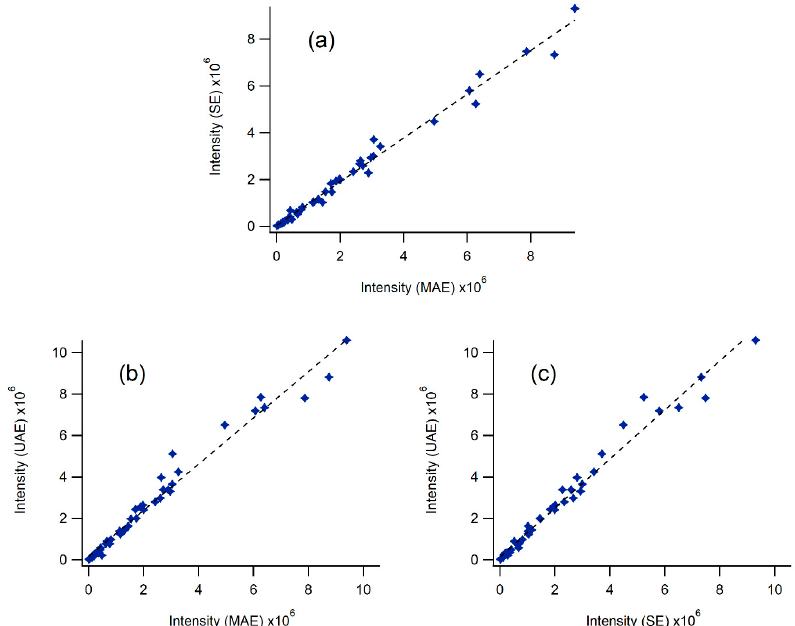
Figure 10. Comparison of LC-MS signals for 45 compounds using SE, UAE and MAE extraction techniques with acetone as the solvent. The identities of twenty of these compounds were confirmed with analytical standards. The signal for p-coumaric acid was omitted from these graphs because of its high abundance. The comparisons are as follows: ( a ) SE versus MAE, ( b ) UAE versus MAE and ( c ) UAE versus SE.